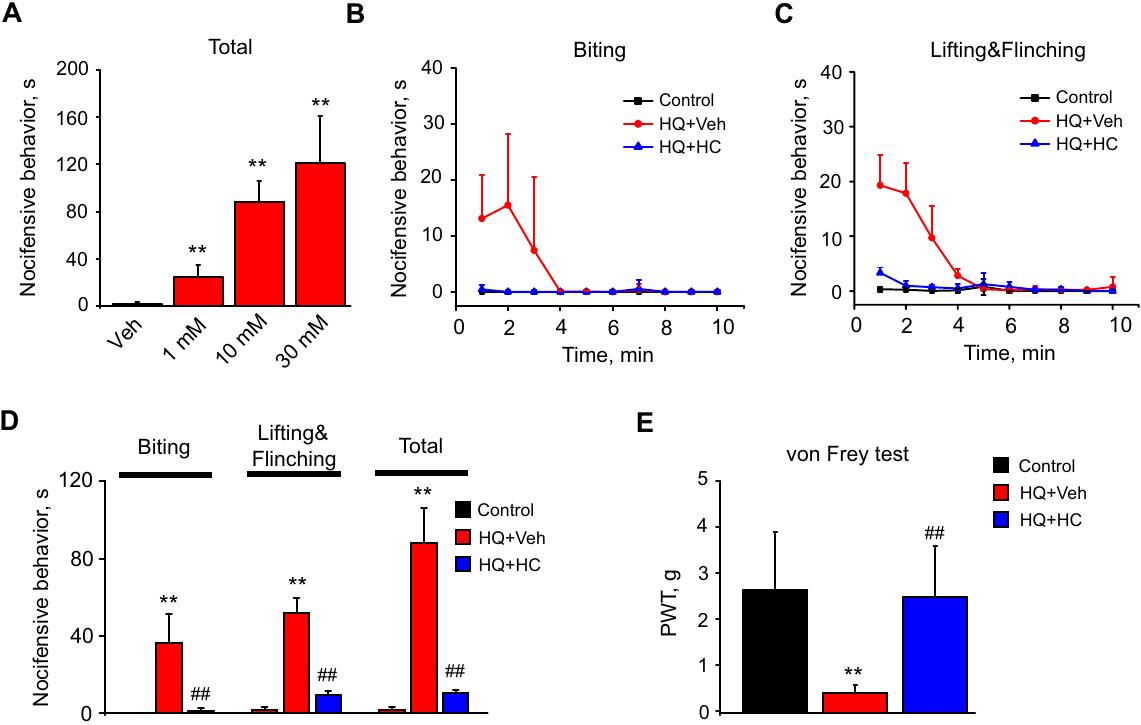
Figure 7. HQ induces acute nocifensive behavior and long-lasting mechanical hyperalgesia through a TRPA1- dependent mechanism in mice. ( A ) HQ dose-dependently elicited nocifensive behavior in mice when injected into the hind paw. Vehicle (PBS) or 1 mM, 10 mM, 30 mM HQ in 20 µ l volume was administered to the hind paw through intraplantar injection. Total nocifensive responses (the time mouse spent on paw biting, lifting and flinching) were summarized. n = 5–8 mice/group. ( B,C ) Time course of mouse biting ( B ), lifting & flinching ( C ) behavior after intraplantar injection of vehicle (Control), HQ (HQ, 10 mM) + vehicle or HQ (HQ, 10 mM) + HC-030031 (HC, 10 µ g). ( D ) Averaged effect of HC-030031 on HQ-induced nocifensive behavior, including biting, lifting&flinching and total. ( E ) Paw withdraw threshold (PWT) of mice measured by von Frey hair testing. Tests were carried out 1.5 hour after vehicle, HQ + Veh or HQ + HC-030031 injection into the hind paw. n = 7–8 mice/group. ** p < 0.01 vs . vehicle or control group, ## p < 0.01 vs . HQ